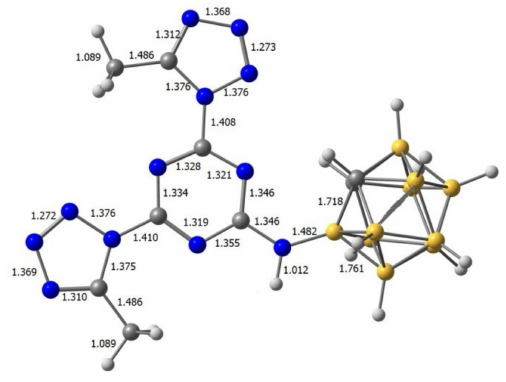
Figure 9. Calculated geometry of compound 10 .